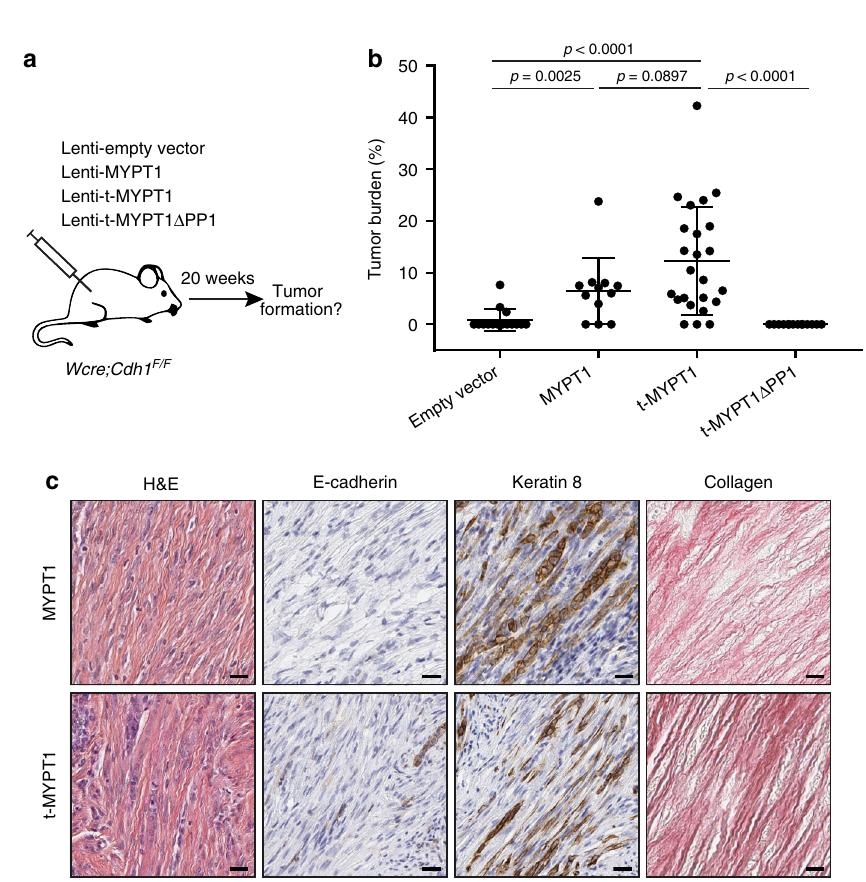
Fig. 7 Relaxation of actomyosin contractility drives ILC formation. a Schematic representation of intraductal injections performed in WapCre ; Cdh1 F/F mice with high-titer lentiviruses produced from vectors encoding MYPT1-wt, t-MYPT1, t-MYPT1 Δ PP1, or empty vector (EV). b Quanti fi ed tumor burdens of Wcre;Cdh1 F /F females 20 weeks after intraductal injection of Lenti-EV ( n = 16 glands), Lenti-MYPT1-wt, ( n = 12 glands), Lenti-t-MYPT1 ( n = 24 glands), or Lenti-t-MYPT1 Δ PP1 ( n = 14 glands). Data are depicted as mean ± standard deviation. p values were calculated using an unpaired two-tailed t -test. c Representative images of tumor sections stained with H&E or stained for E-cadherin and CK8 and Collagen (Sirius red). Scale bar is 20 µ M. Source data are provided as a Source Data fi